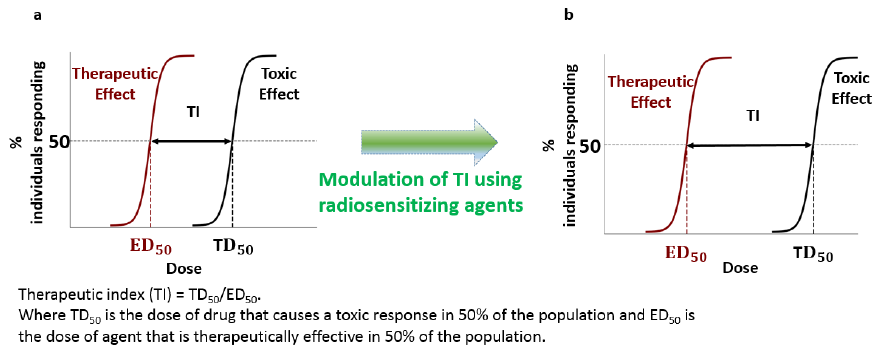
Figure 1. Modulation of therapeutic index (TI) using radiosensitizing agents. ( a ) Variation of the local tumour control probability (red) and normal tissue complication (black) for single treatment option. ( b ) Combination of therapeutic agents could improve the therapeutic window.